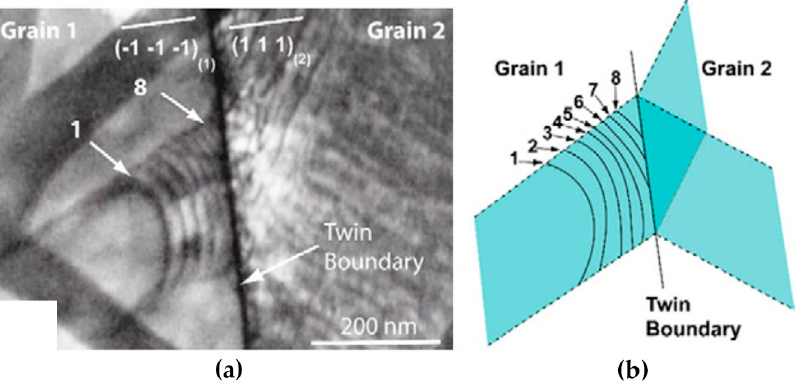
Figure 16. The process of dislocation transmission across a coherent twin boundary. ( a ) TEM image and ( b ) sketch showing dislocation pile-ups in front of a twin boundary, and the dislocation transmission by direct and indirect modes. (Reprinted from Reference [101], with permission from Elsevier).